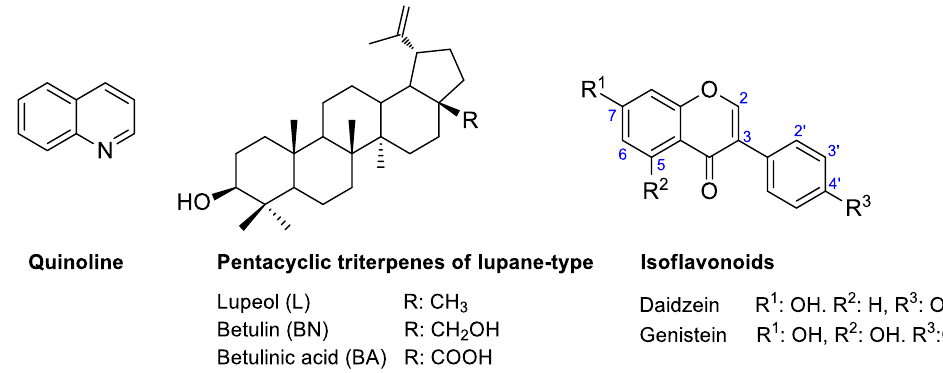
Figure 7. Selected natural bioactive compounds.